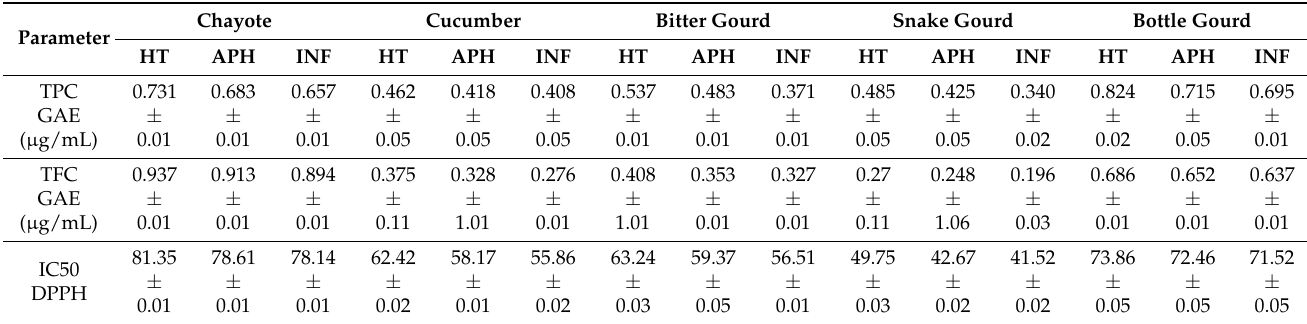
Table 1. Total phenolic and flavonoid contents and DPPH activity in healthy, apparently healthy, and infected tissues during melon fly infection to combat infection-induced biotic stress (mean ± SD). Parameter